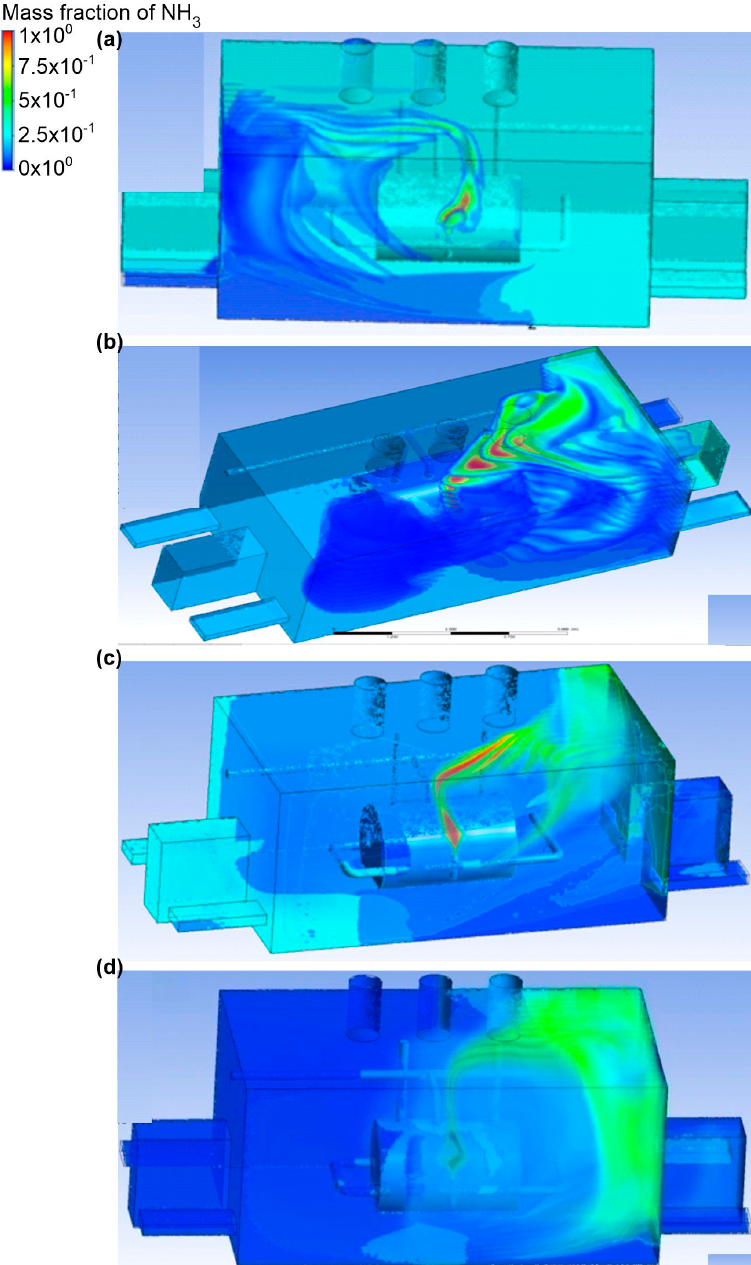
Figure 12. Ammonia distribution in the engine room for: ( a ) scenario A, ( b ) scenario B, ( c ) scenario C, and ( d ) scenario D.